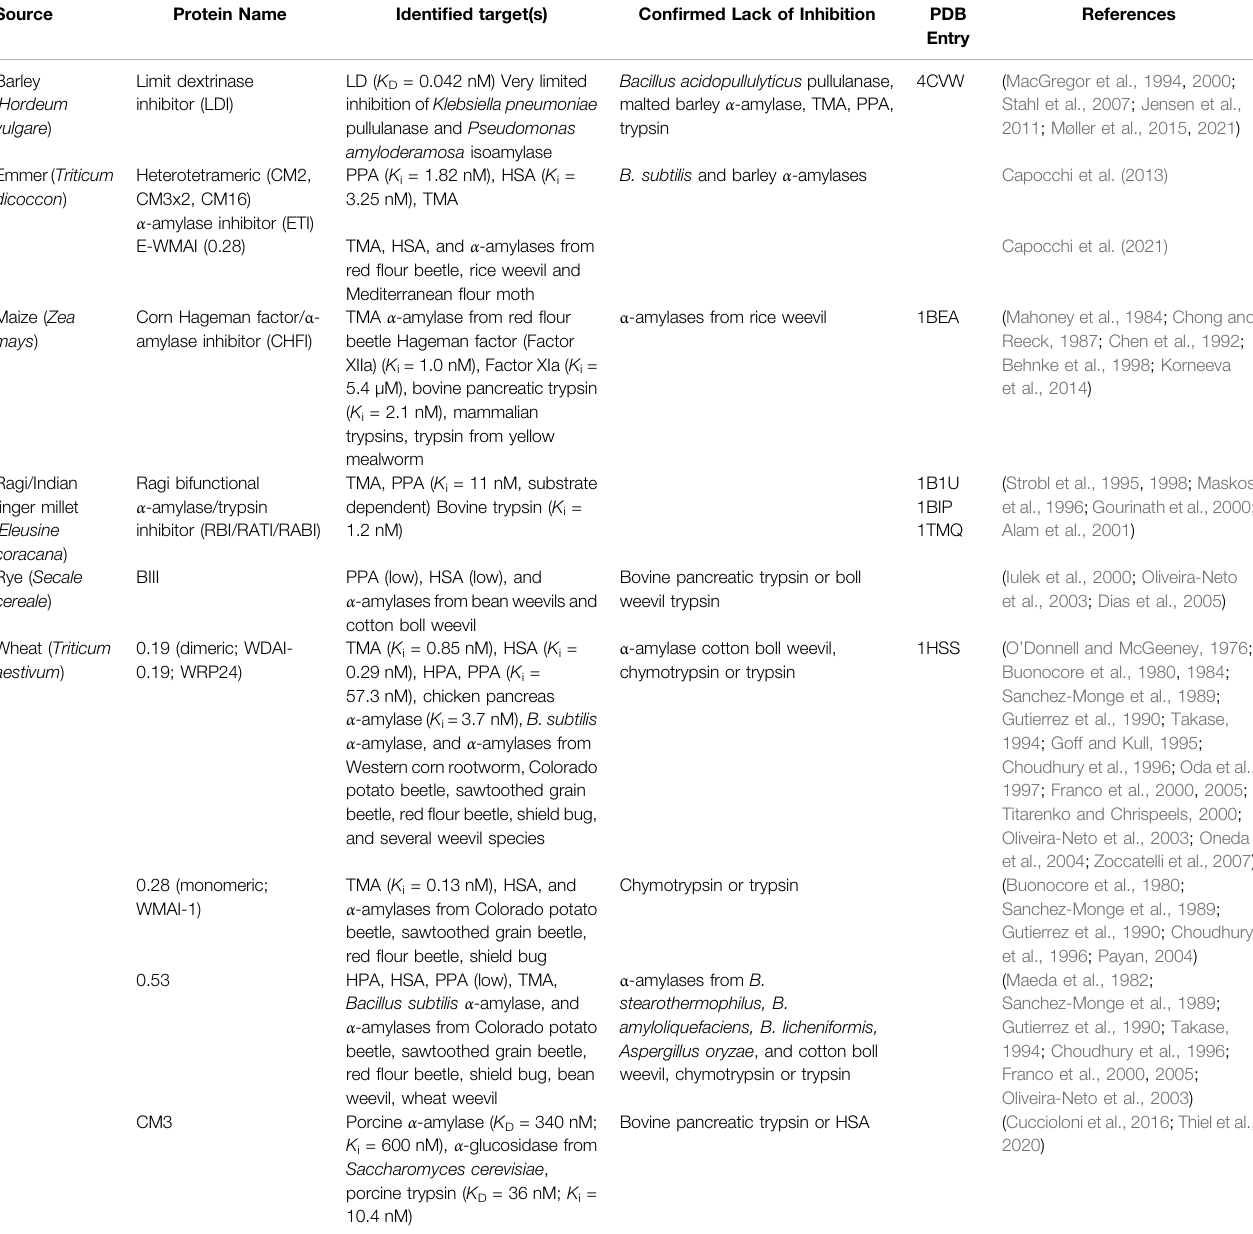
TABLE 1 | Biochemically well-characterized cereal type inhibitors. The Protein Data Bank (PDB) entries are given for structure-determined proteins. Abbreviations of enzymes mentioned in the table: HPA, human pancreatic α -amylase; HSA, human salivary α -amylase; LD, barley limit dextrinase; PPA, porcine pancreatic α -amylase; TMA, yellow mealworm α